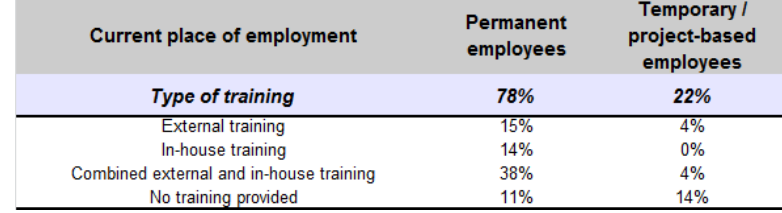
Table 18 - The training of permanent and temporary employees